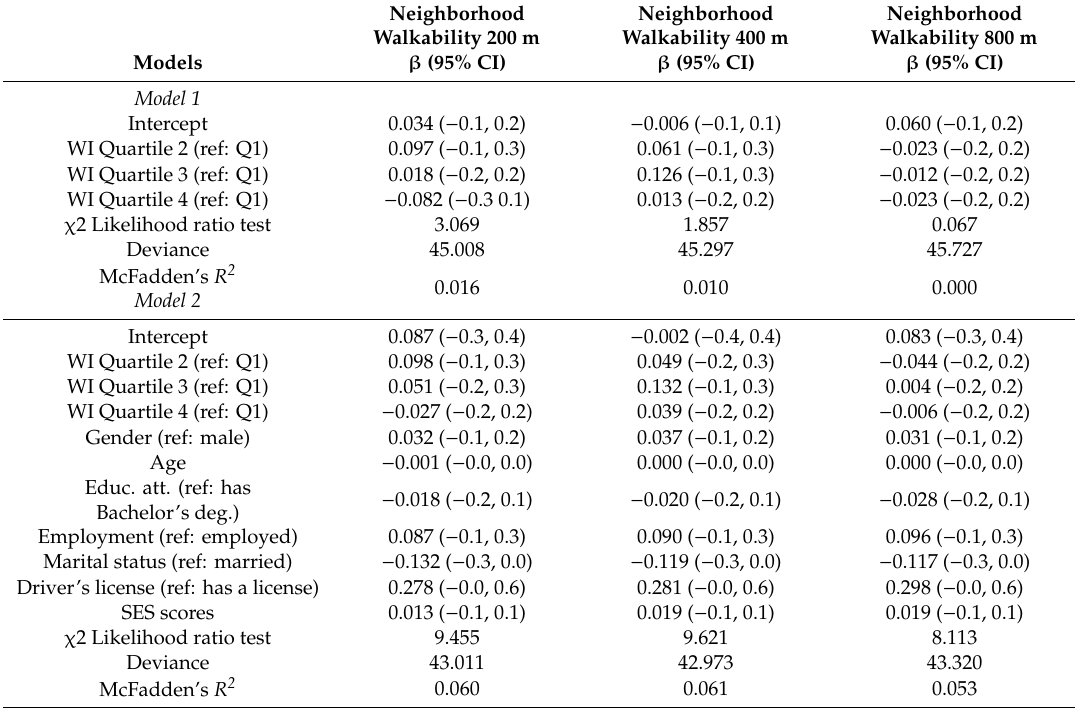
Table 4. Results of the gamma GLM for time spent eating